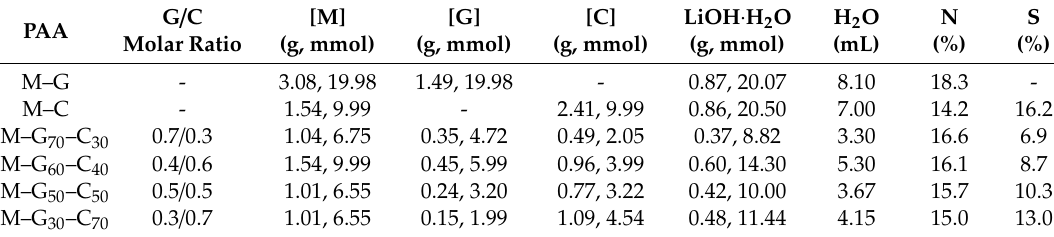
Table 1. Chemical composition and amounts of reagents used in PAA synthesis.